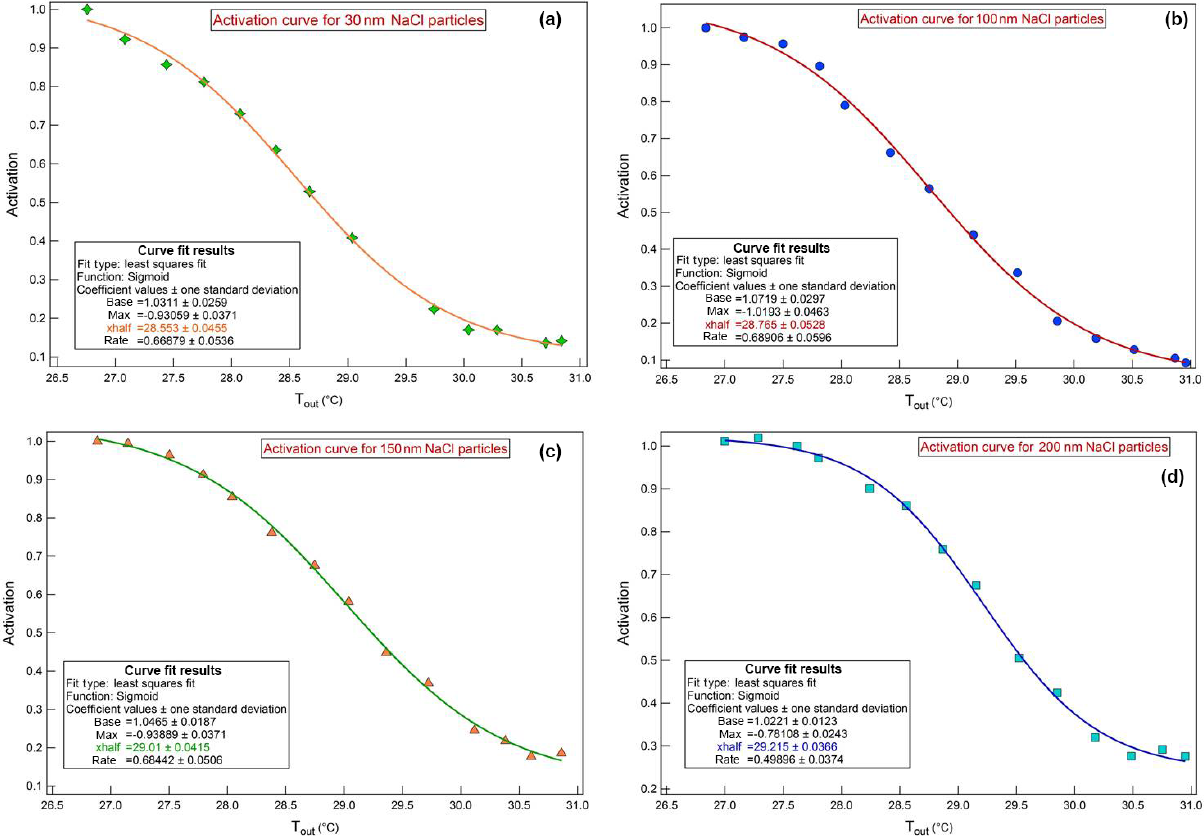
Figure 7. Determination of the critical supersaturation for four different activation